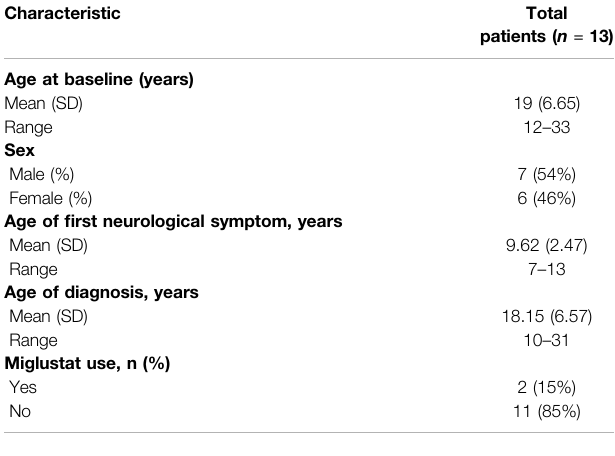
FIGURE 1 | CONSORT fl ow diagram of patient recruitment until the 12- months follow-up.